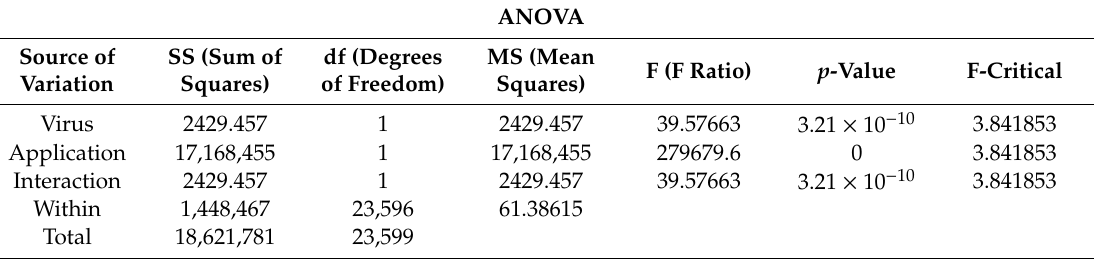
Figure 5. Decomposition of the time series dataset. Based on our experimental analysis, ARIMA (2,0,0) (1,1,0) [60] with drift was found to be the most suitable model. This model obtained an AIC of 792012.8. The value of p was 2, which indicates the relationship between an observation with that of the one preceding the one immediately preceding it. The zero value of d indicates that the integrative component was absent. The value of zero for q indicates no relationship between an error and the ones preceding it. The presence of seasonality in the model indicates repetitions of the same events. In our analysis, the repetitions or seasonality depends on the time at which certain applications or the virus were executed. As in real time such an event varies from one situation to another, the seasonality value indicated by the proposed model was not significant in this study.